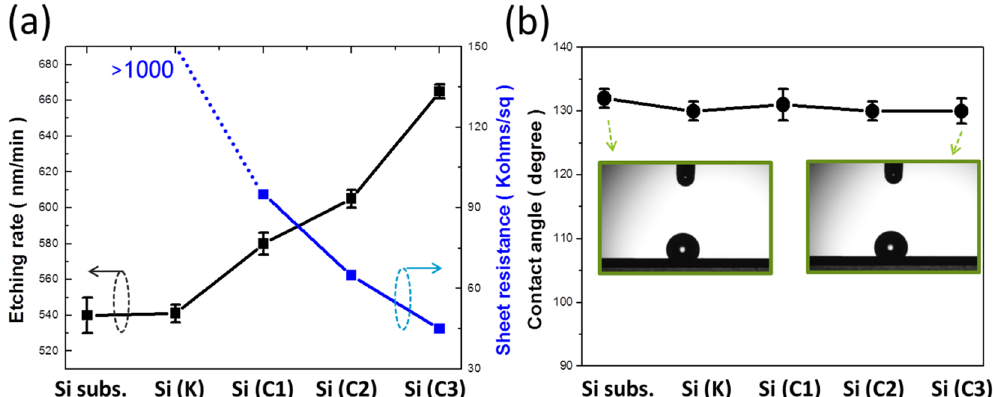
Figure 3. ( a ) Dependence of etching rates on the types of Si substrates: bare Si substrate (Si subs.), Si substrate with nonconductive tape (Si (K)), Si substrate with one-layer (Si (C1)), two-layer (Si (C2)) and three-layer (Si (C3)) conductive carbon tapes. The corresponding sheet resistances of back substrates were also presented. ( b ) Contact-angle measured results of Si nanowire arrays formed by various types of Si